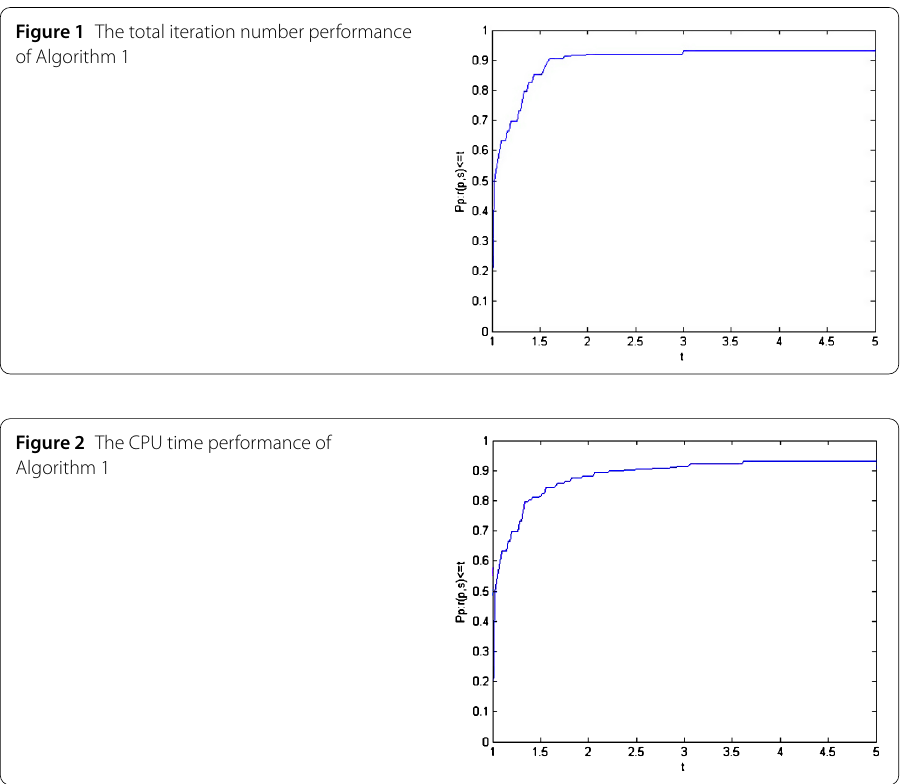
Figure 1 The total iteration number performance of Algorithm 1